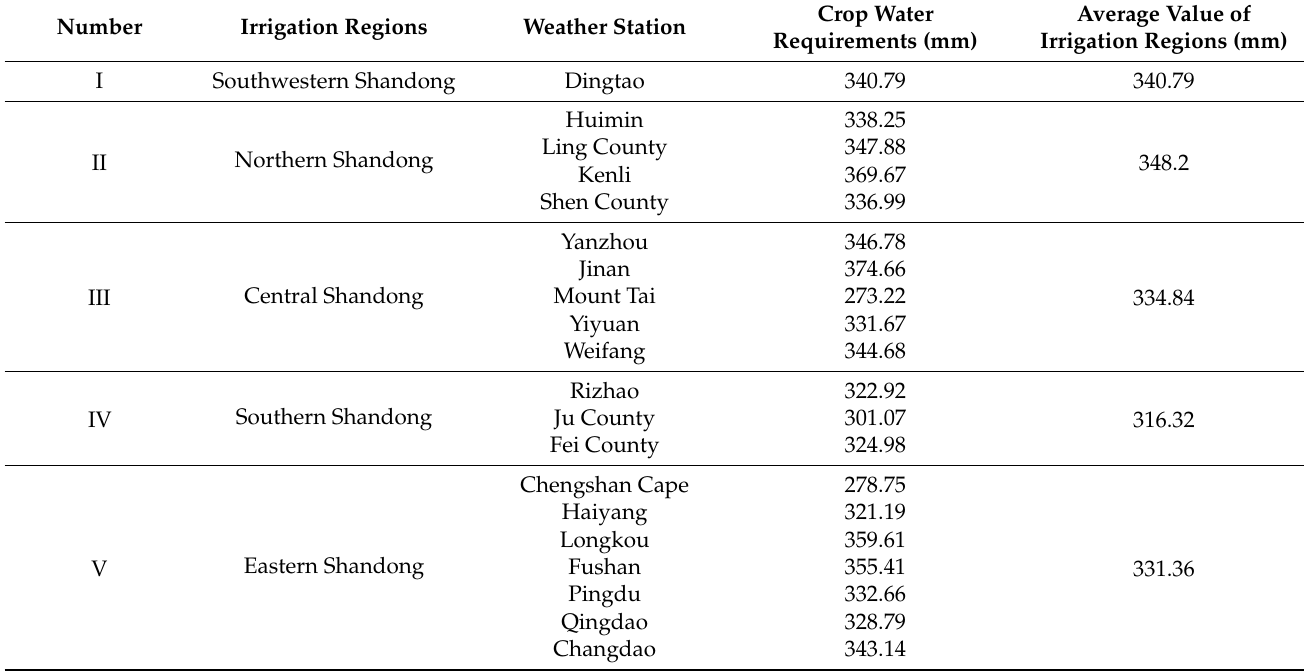
Table 1. The multi-year average of water requirements for summer maize crops from 1968 to 2016.